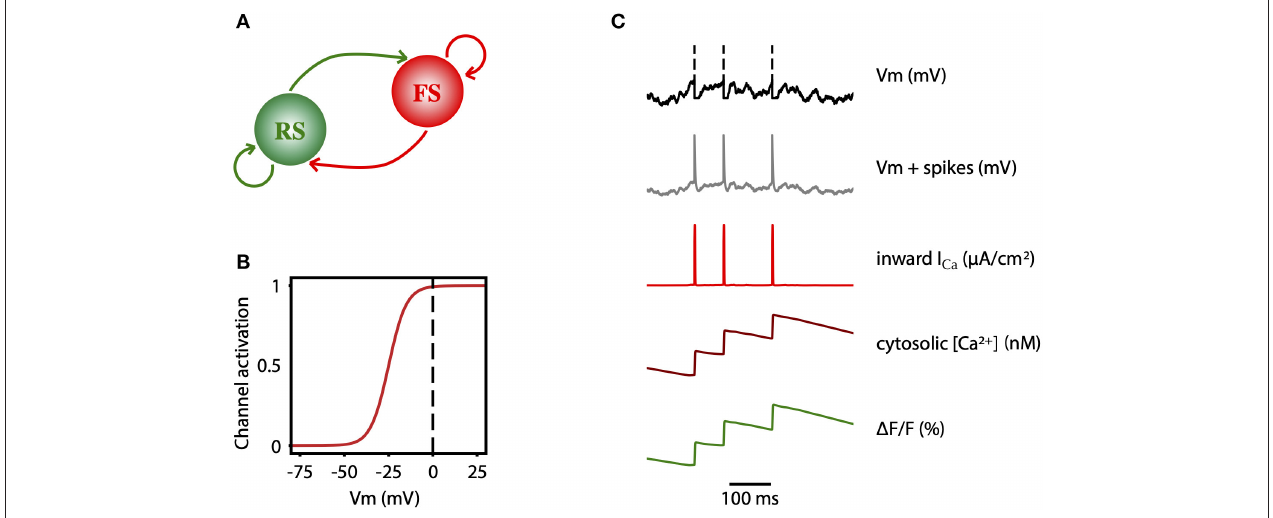
FIGURE 7 | Two-photon calcium signal model from a spiking network model. (A) Schematic connectivity between the excitatory population of regular spiking (RS) neurons and the inhibitory population of fast spiking (FS) neurons of the modeled cortical network. (B) Activation curve of a high-voltage activated calcium channel that is used to compute the inward calcium current ( I Ca ) from the changes in the V m . (C) From top to bottom, simulated membrane potential of a neuron emitting three spikes which are represented by dashed lines, membrane potential with reconstructed spikes, inward calcium current associated with changes in the membrane potential, cytosolic calcium concentration, and fluorescence emitted by the calcium indicator due to the intracellular concentration of calcium.